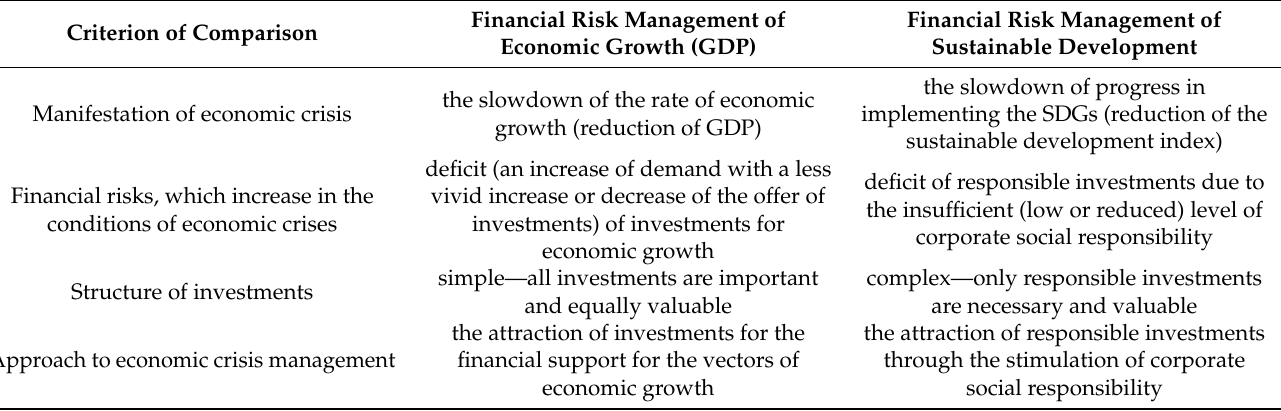
Table 1. Comparative analysis of financial risk management of sustainable development and financial risk management of economic growth